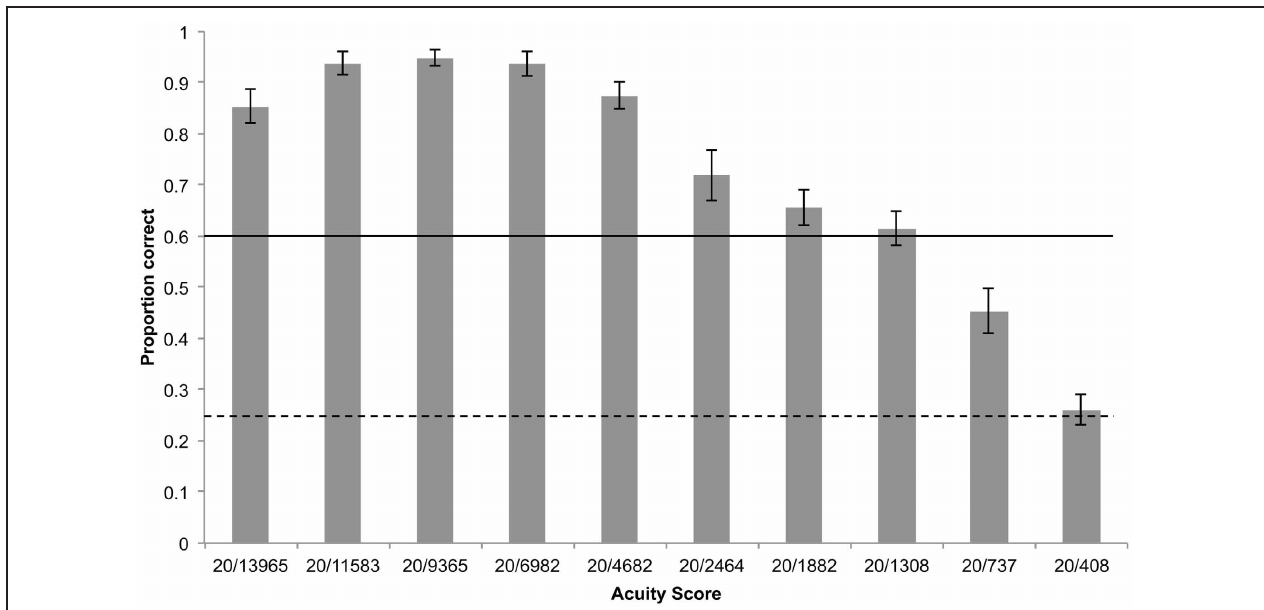
FIGURE 6 | Mean proportion of correctly identified static optotype orientations by all participants for each block, shown on the X-axis as its corresponding acuity score. Error bars represent standard error of the mean, horizontal solid line represents threshold of 0.6 (8/12 correct responses), dashed line represents chance performance.